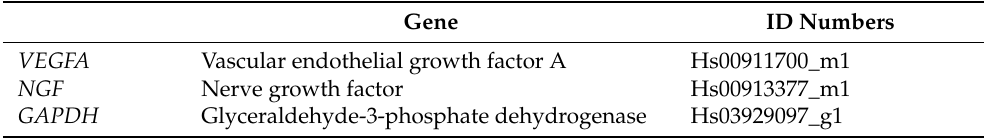
Table 3. Reverse transcription PCR primers.